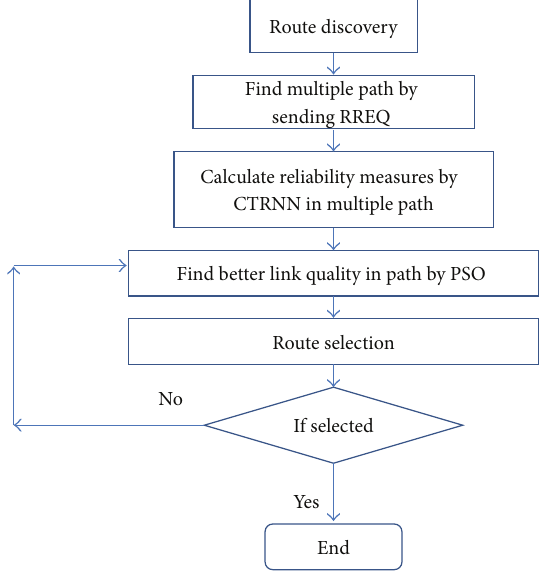
Figure 1: Flow diagram of the proposed